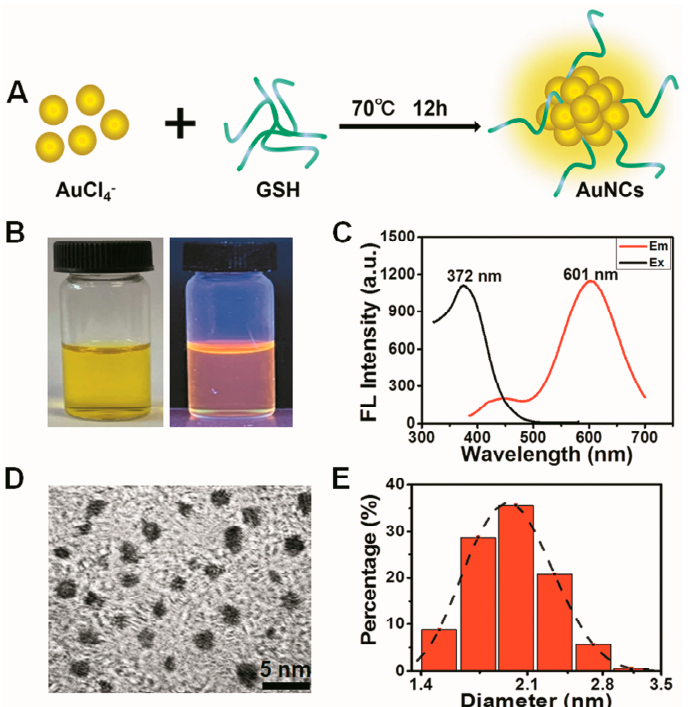
Figure 1. Characterization of GSH-protected gold nanoclusters. ( A ) Schematic of the synthesis of GA. ( B ) Visible (left) and ultraviolet (right) pictures of the GA solution. ( C ) Fluorescence excitation (375 nm) and emission spectra (601 nm) of GA. ( D ) Image of GA captured with a high-resolution transmission electron microscope (HRTEM). ( E ) Hydrated particle size distribution of the synthesized Au nanoclusters.